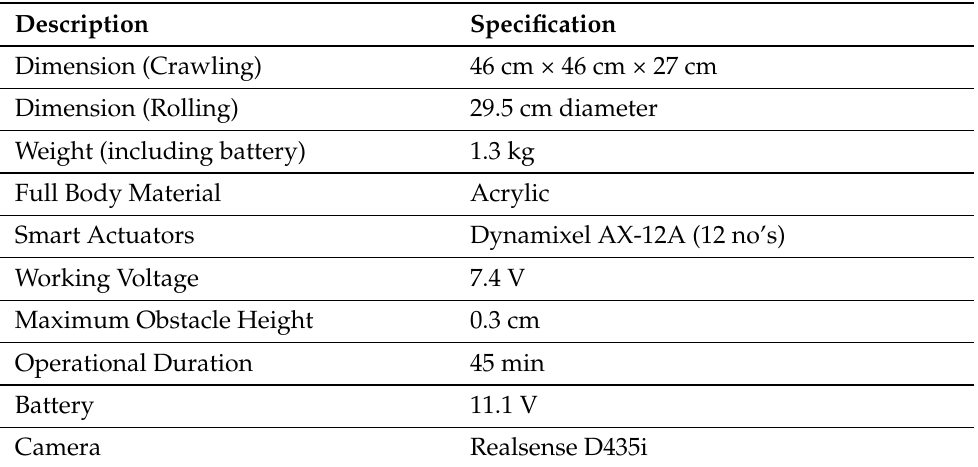
Table 1. Technical specifications of Scorpio.